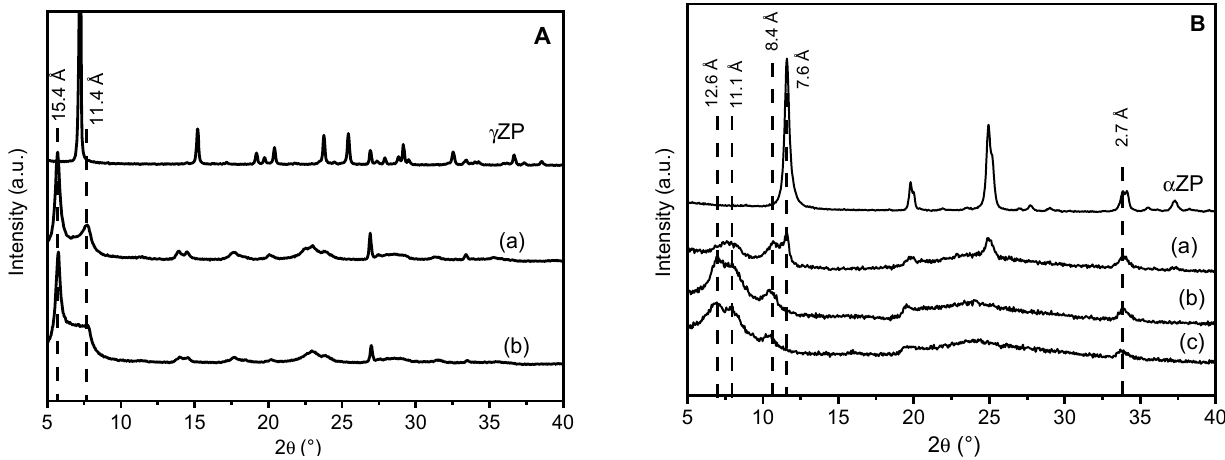
Figure 1. Frame ( A ) XRD of γ ZP: γ ZP05 (a) and γ ZP1 (b). Frame ( B ) XRD patterns of α ZPg, α ZP05 (a), α ZP1 (b), and α ZP2 (c). All samples were conditioned over BaCl 2 (90% RH). α ZP is also a layered compound, and the structure of the layers is simpler than γ ZP, as each α -layer consists of a plane of zirconium atoms coordinated by tridentate HPO 4 groups, which occupy both faces of the layers. Although these hydrogen phosphate